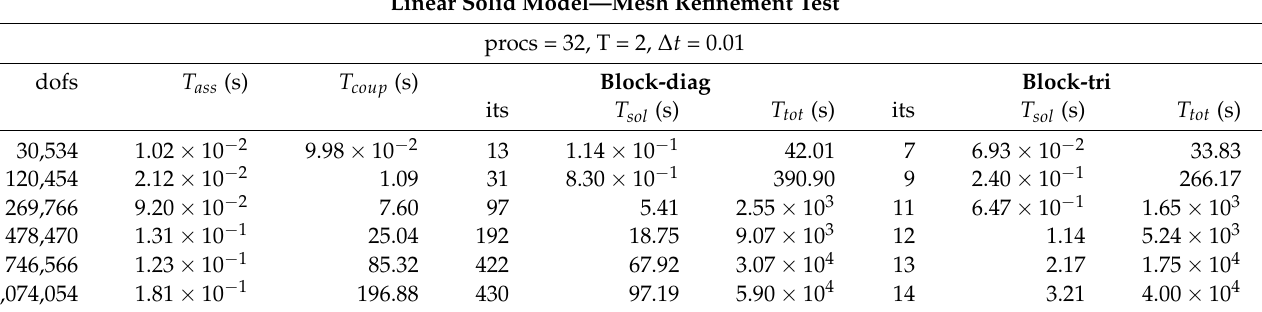
Table 1. Refinements of the mesh in the linear solid model. The simulations are run on the Shaheen cluster. procs = number of processors; dofs = degrees of freedom; T ass = CPU time to assemble the stiffness and mass matrices; T coup = CPU time to assemble the coupling term; its = GMRES iterations; T sol = CPU time to solve the linear system; T tot = total simulation CPU time. The quantities T coup , its and T sol are averaged over the time steps. All CPU times are reported in